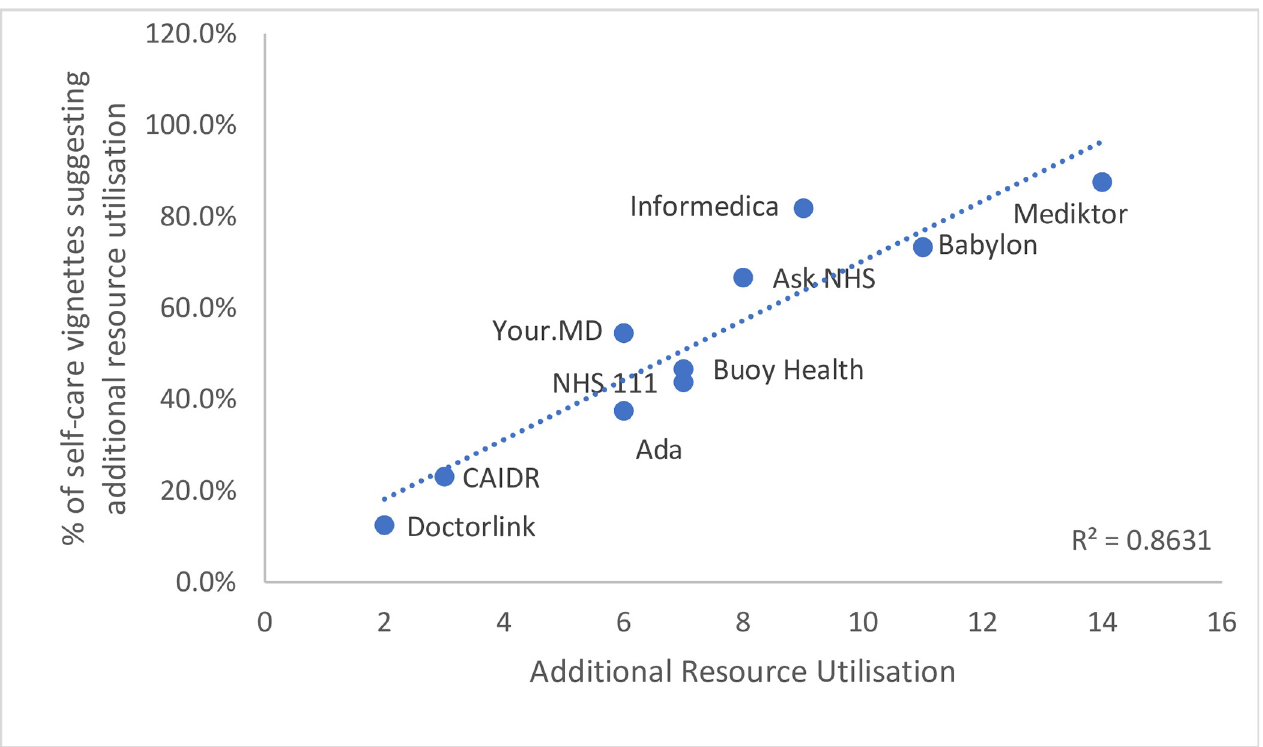
Fig 7. Correlation of additional resource units for self-care specific